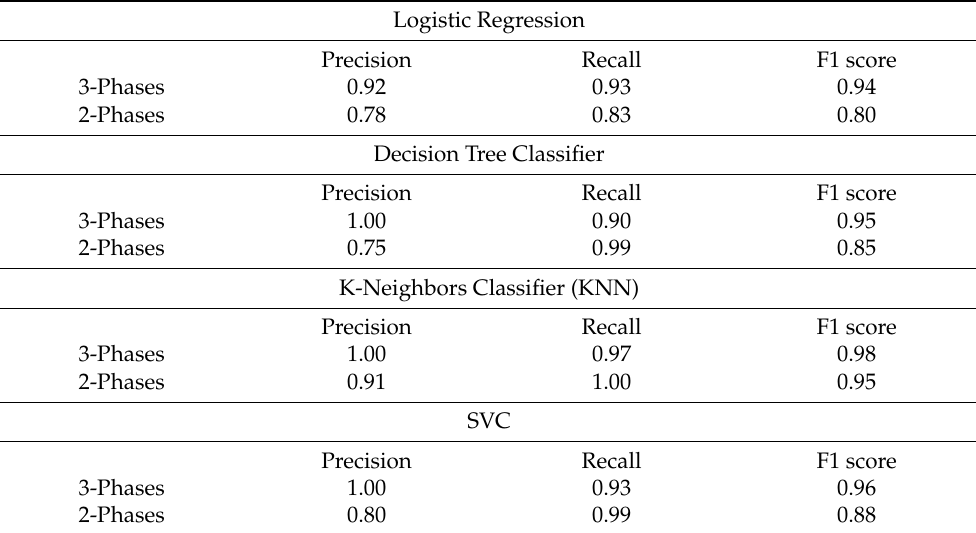
Table 6. Classification Phase Report — Strategy 1.